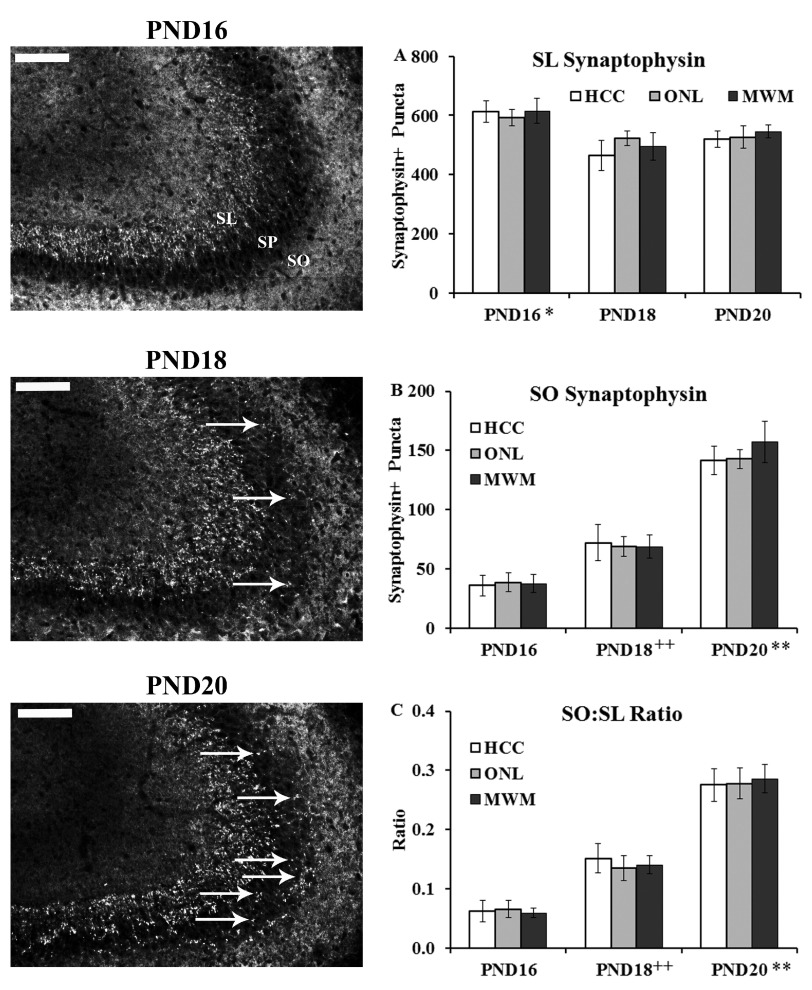
Synaptophysin staining in the CA3 region as an indicator of mossy fiber (
MF) projections.Brains from PND16, PND18 and PND20 from home cage control (HCC), object in a novel location (ONL) or Morris water maze (MWM) groups were removed and processed immunohistochemically for synaptophysin staining in the CA3 region as a marker for MF connectivity. Left panels show representative staining from the three age groups (images from MWM condition). Abbreviations: SO:
stratum oriens; SP:
stratum pyramisale; SL:
stratum lucidum. Arrows point to synaptophysin-positive puncta in the SO region. Scale bar = 100 µm. (
A) Synaptophysin-positive puncta quantified in the SL region revealed a main effect of age with group PND16 showing more staining than PND18 and PND20 (*, p < 0.05). (
B) Synaptophysin-positive puncta quantified in the SO region revealed a main effect of age with group PND18 showing more staining than PND16 (++, p < 0.01) and group PND20 showing more staining than groups PND16 and PND18 (**, p < 0.01). (
C) Ratio of synaptophysin-positive puncta quantified in the SO: SL region (to control for potential size variation) revealed a main effect of age with group PND18 showing more staining than PND16 (++, p < 0.01) and group PND20 showing more staining then groups PND16 and PND18 (**, p < 0.01).